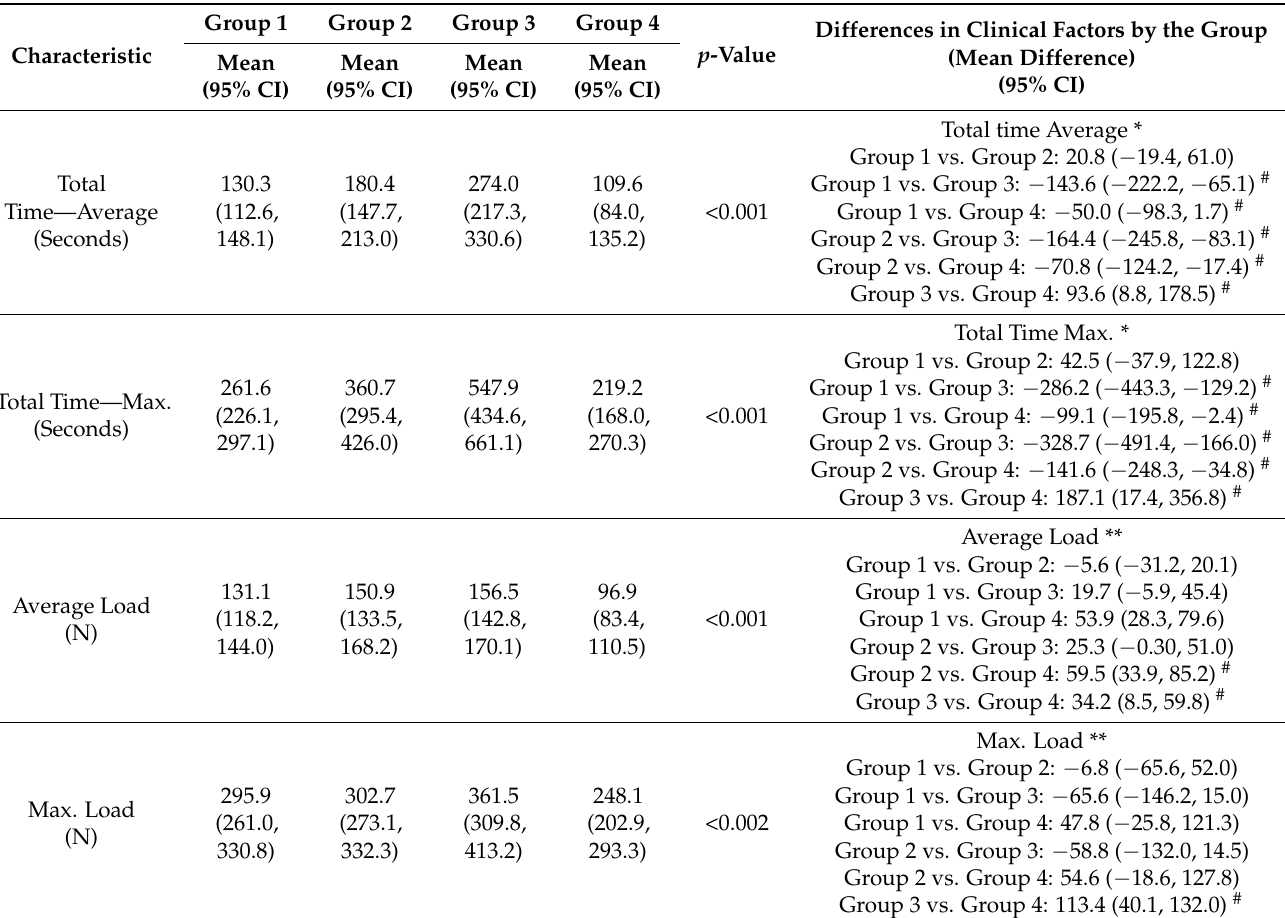
Table 2. Means with 95% confidence intervals for each factor and differences in clinical factors by the